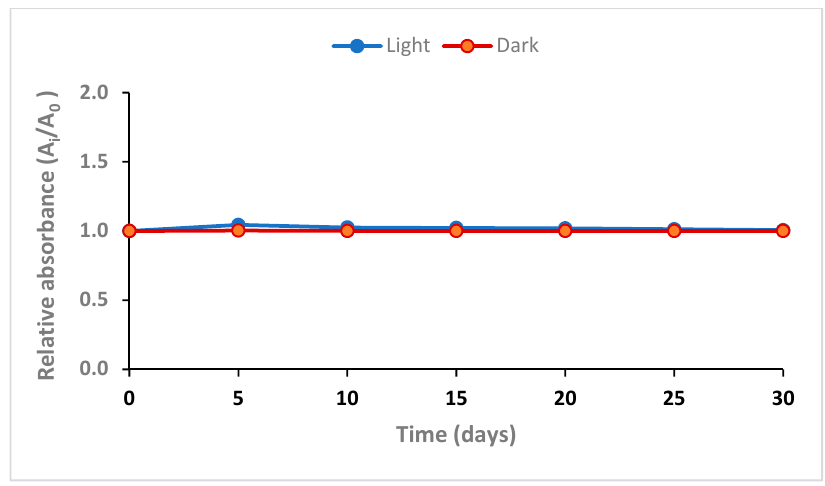
Figure 1. Post-irradiation stability of PVANBT films stored in dark and light at room temperature, λ max = 430 nm.